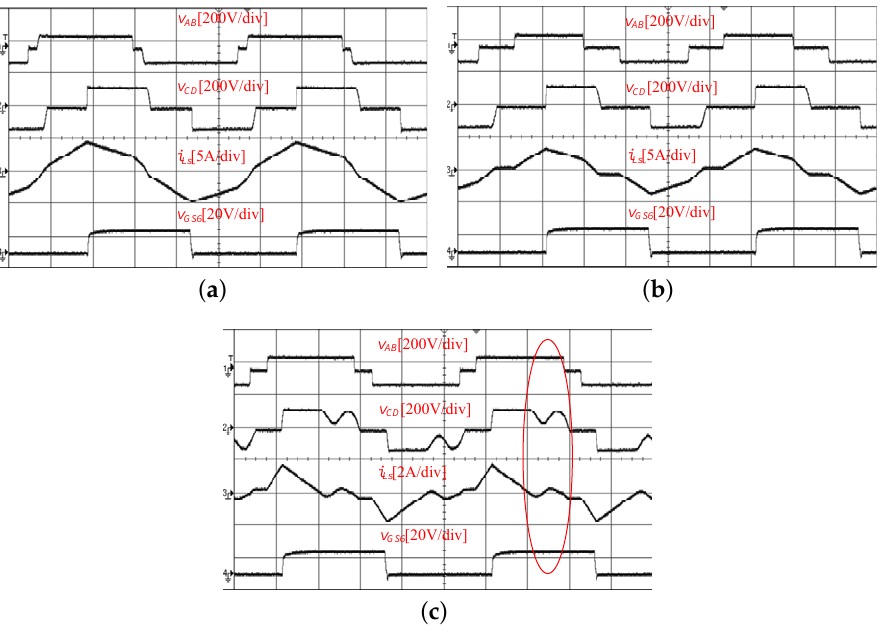
Figure 11. Experimental waveforms of v AB , v CD , i Ls and V GS 6 (from top – bottom ), time scale: (2 µ s/div), ( a ) Mode A; ( b ) Mode B; ( c ) Mode C.